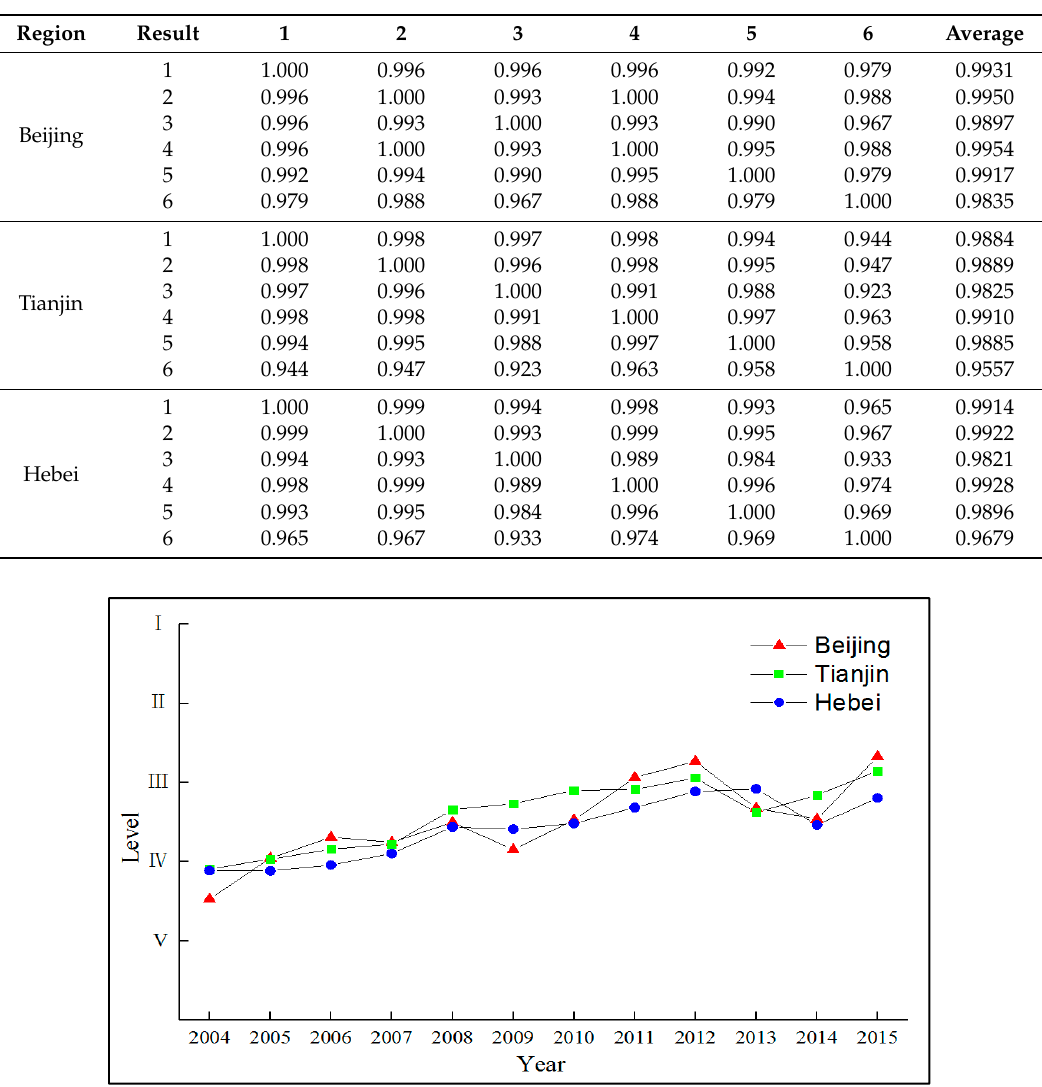
Table 10. Spearman correlation coefficient analysis results (Beijing-Tianjin-Hebei).